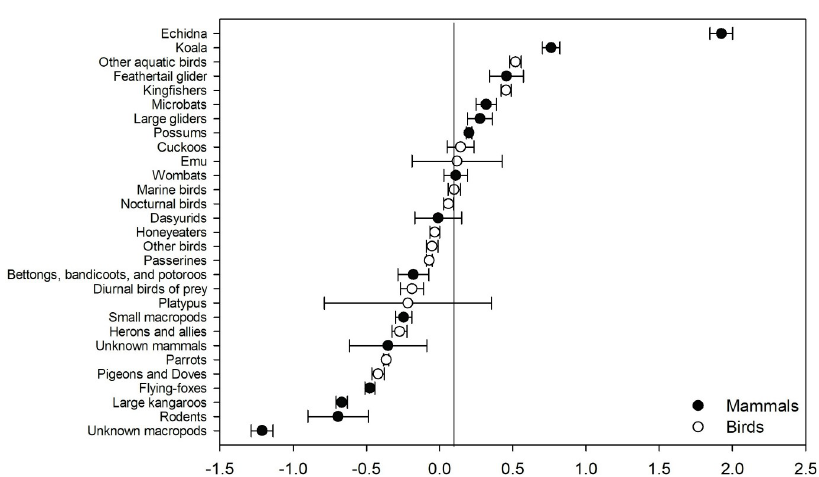
Fig 12. Response coefficients indicating the relative positive or negative response of bird and mammal subgroups amongst each